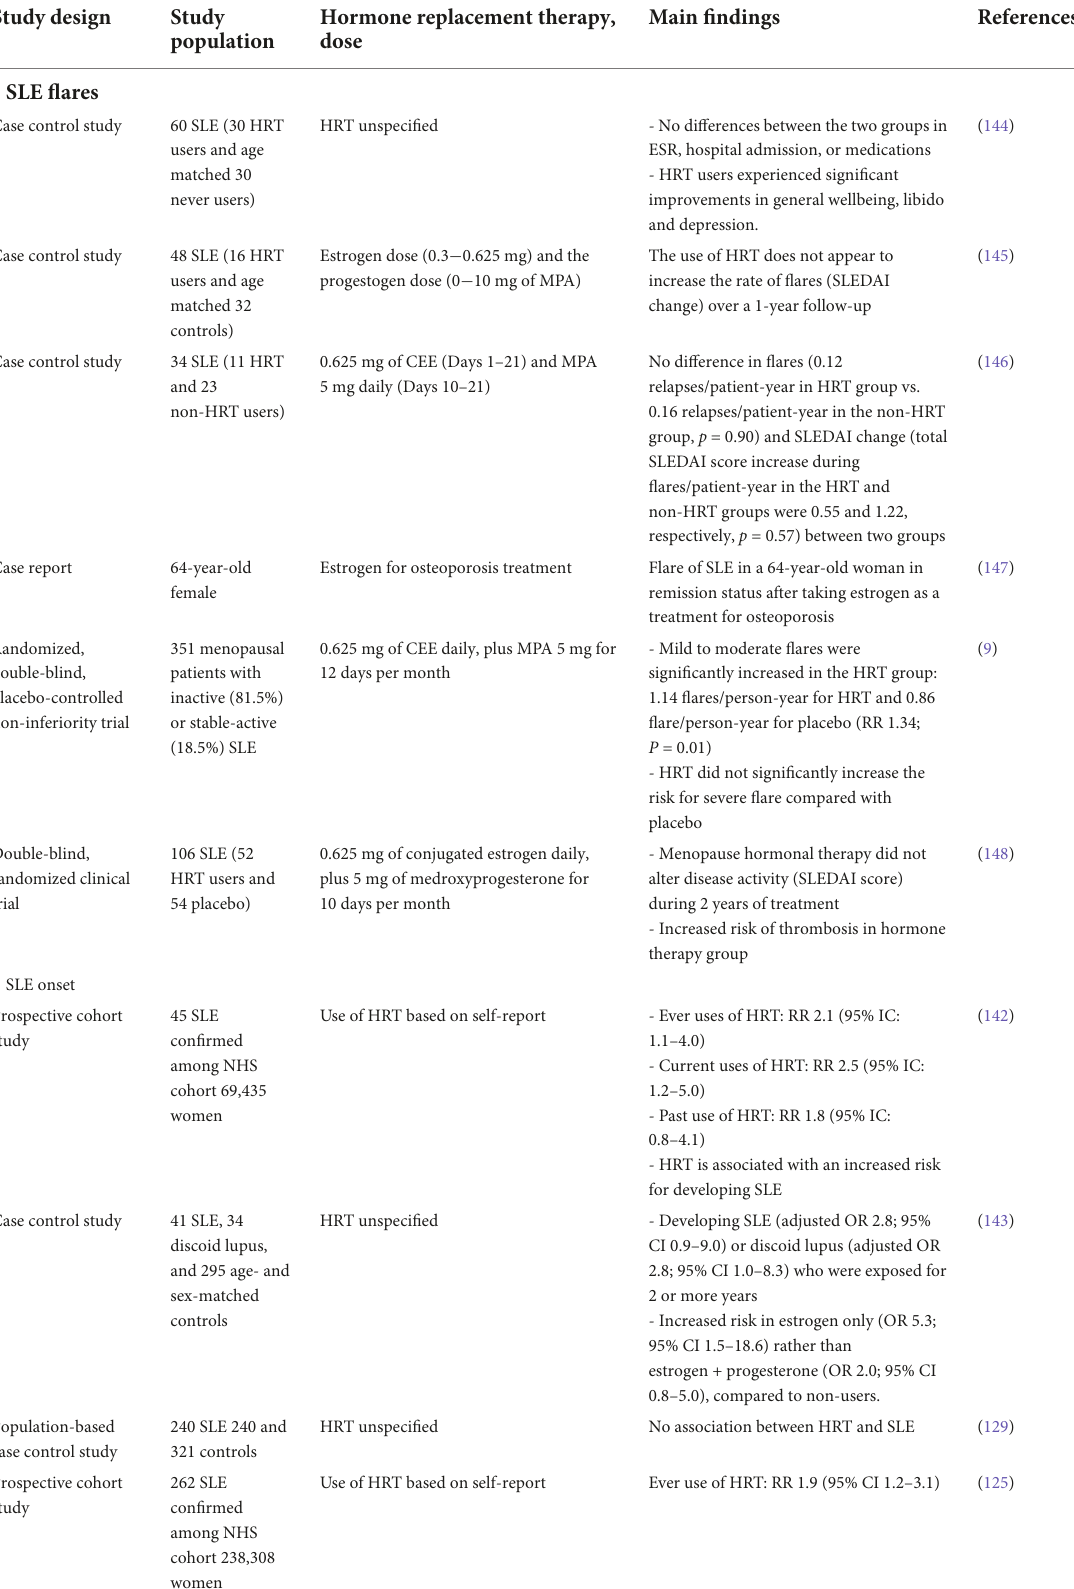
TABLE 2 List of studies on the risk of disease onset or flares in patients with systemic lupus erythematosus using hormone replacement therapy. Study